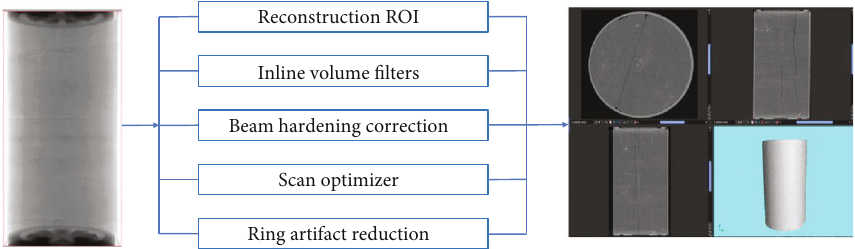
Figure 3: The reconstruction process of CT data.